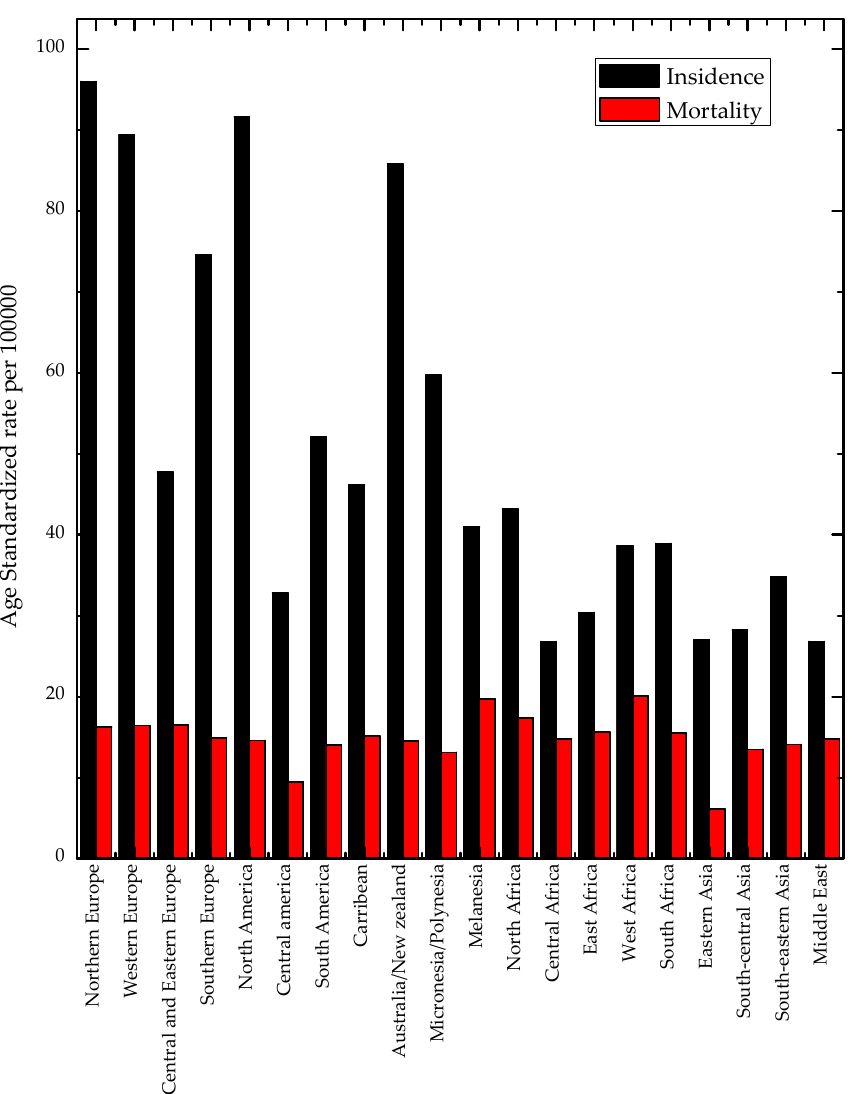
Figure 1. Breast cancer incidence and mortality rates by world area [1].